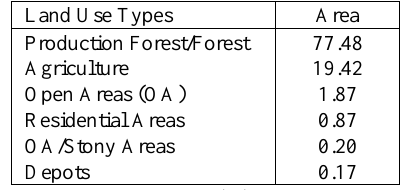
Table 3. Areal distribution (%) of the land use types